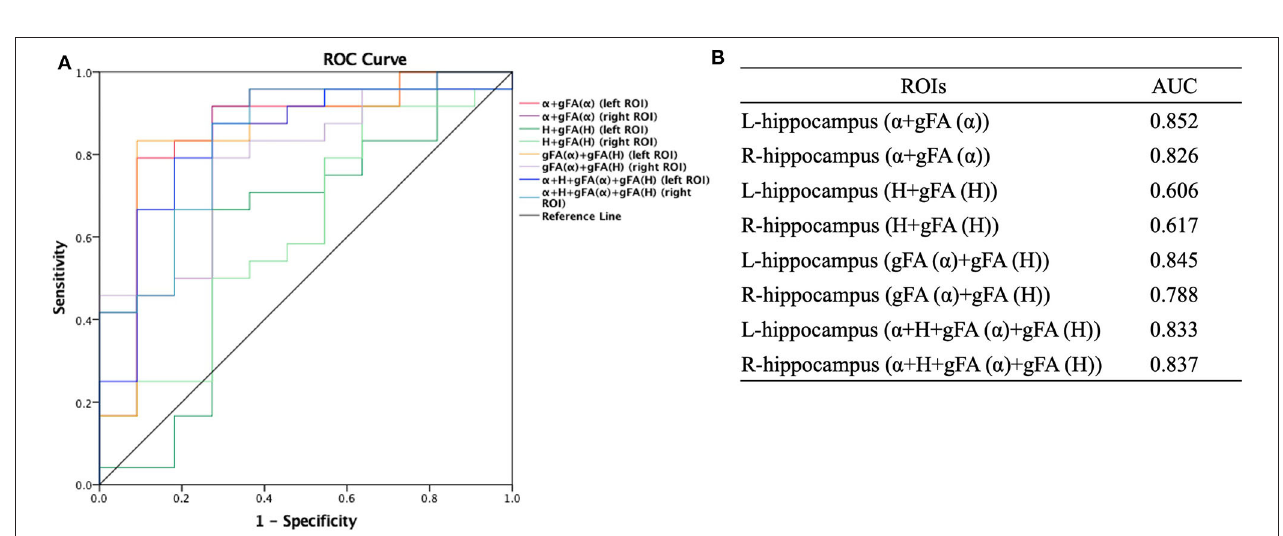
FIGURE 7 | Receiver-operating characteristic (ROC) curve was generated using the individual gFA values and directionally averaged values of α , H , and ADC for differentiating healthy controls and AD patients. (A,B) The area under the curve (AUC) of gFA( α ) values of the bilateral hippocampus (AUC = 0.801, AUC = 0.758, separately) was larger. ROC, receiver operating characteristic; ROI, region of interest; gFA, generalized fractional anisotropy; ADC, apparent diffusion coefficient; AD, Alzheimer’s disease; AUC, area under the curve.